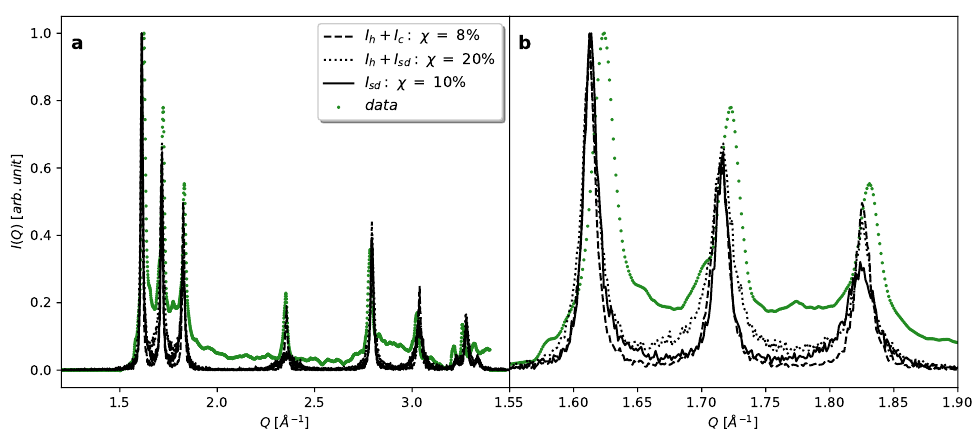
Figure A12. ( a ) Cubicity estimate for cubic and hexagonal mixture calculated from the peak heights of (002) and (101) of the hexagonal ice (black dashed), for hexagonal and stacking-disordered mixture (black dotted) and for pure stacking-disordered ice (solid black) together with the experimental data at 4.41 ms travel time (green circles). ( b ) A zoom-in on the first three peaks of the models and experimental data at 4.41 ms travel time in Q -range of 1.55 to 1.90 Å − 1